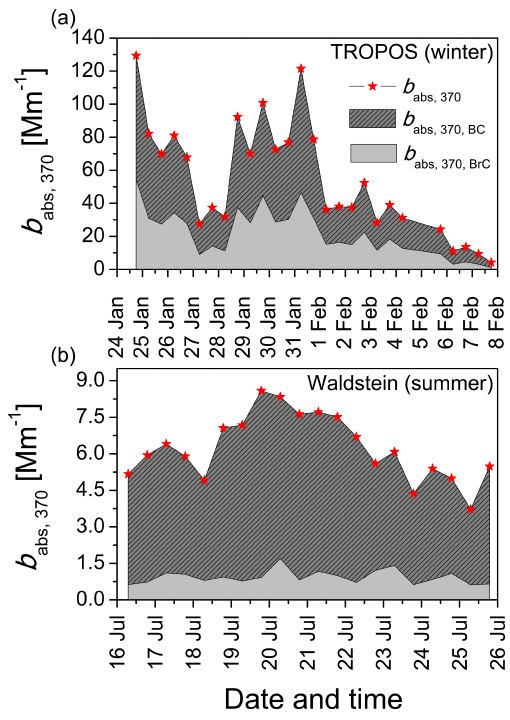
Figure 3. Temporal evolution of the particulate light absorption coefficient b abs at 370nm derived from the aethalometer measure- ments during (a) the TROPOS (winter) campaign and (b) the Wald- stein (summer) campaign. The fractions of black carbon (dark grey area) and brown carbon (light grey area) to the total measured b abs were calculated as described in Eq.